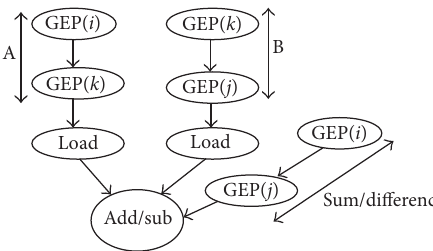
Figure 5: Directed acyclic graph (DAG) of IR for matrix-matrix